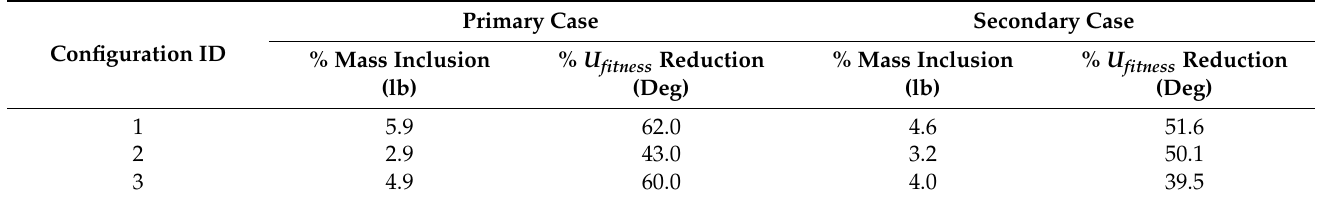
Table 4. Pareto front values for the best individuals under the PSD gust excitation